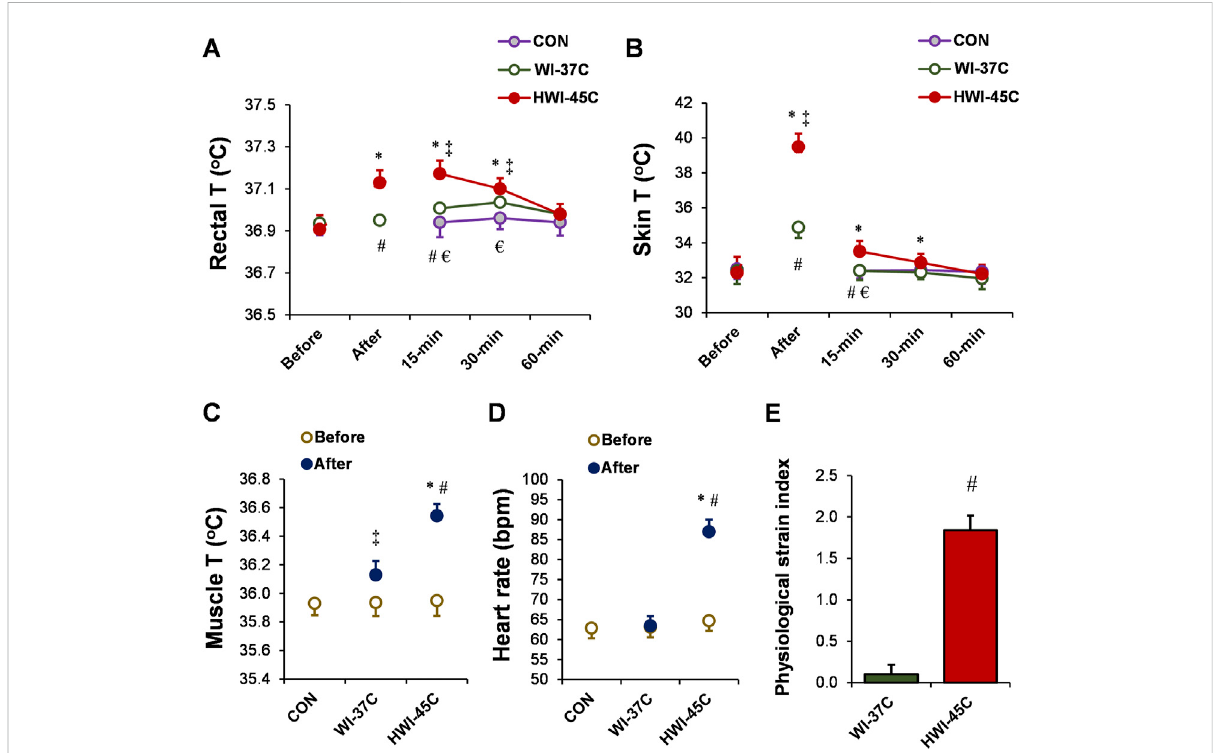
FIGURE 2 Changes in the rectal (A) , skin (B) , and muscle (C) temperatures (T), and heart rate (D) during whole-body immersion in water temperatures of 37 ° C (WI-37 ° C) and 45 ° C (HWI-45 ° C), and the control (CON) condition under a thermoneutral environment. The physiological strain index (E) in WI- 37 ° CandHWI-45 ° C.* p < 0.05,HWI-45 ° Ccomparedwithbefore; ‡ p < 0.05,WI-37 ° Ccomparedwithbefore;# p < 0.05,HWI-45 ° CcomparedwithWI- 37 ° C; € p < 0.05, HWI-45 ° C compared with CON. Values are expressed as mean and